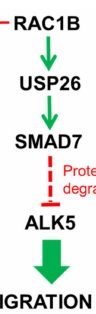
Figure 9. Schematic diagram illustrating the role of SMAD7 in negative regulation of ALK5 protein expression and cell migration by RAC1B. The suppressive e ff ect of RAC1B on cell migration (red line on the left) involves induction of SMAD7 protein through intermittent induction of USP26 (green lines). As a consequence, the RAC1B-induced SMAD7 degrades ALK5 protein, eventually resulting in inhibition of TGF β -induced cell migration. Stimulatory interactions are indicated by green arrows and inhibitory interactions by red